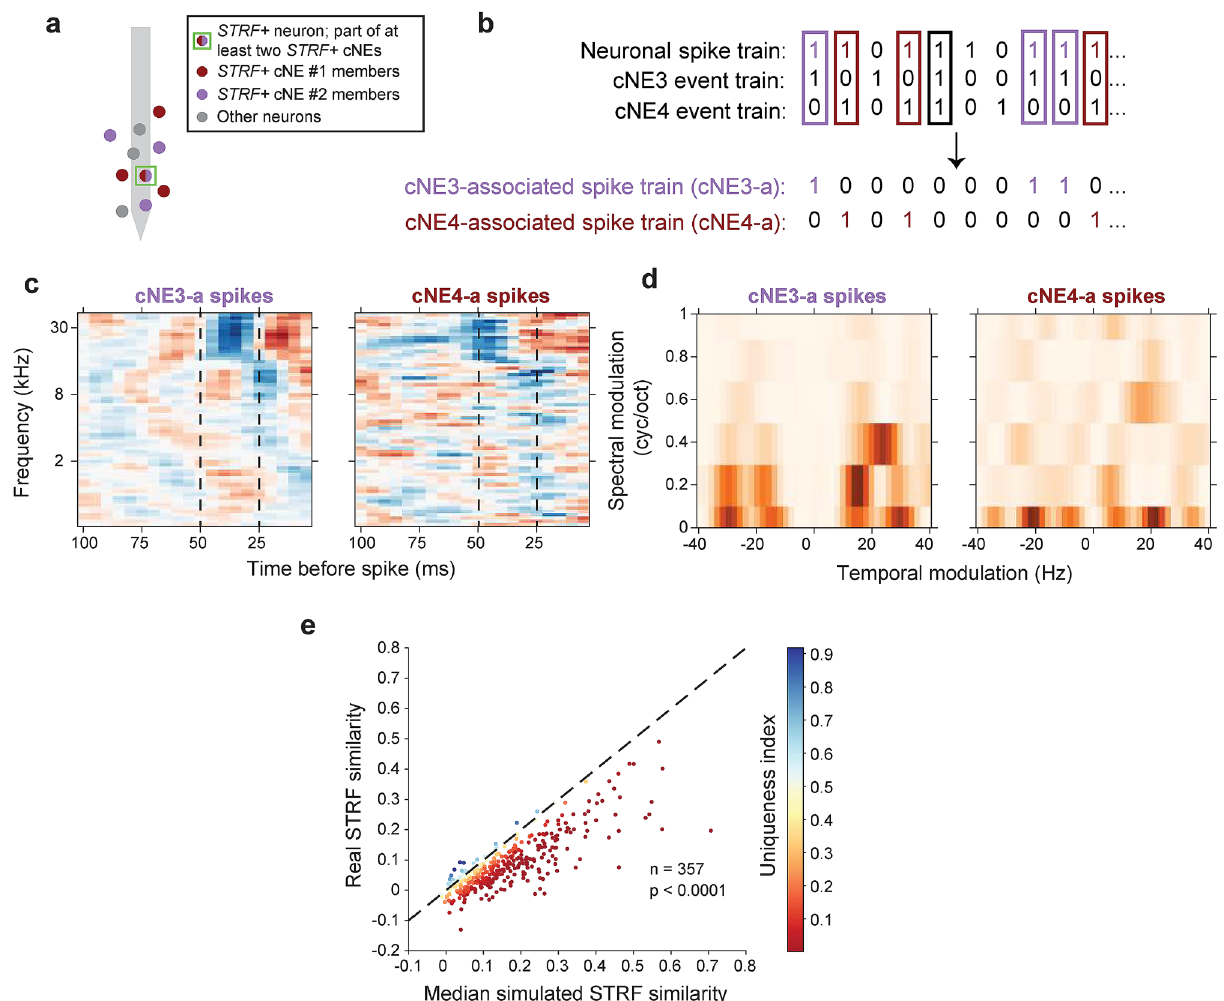
Figure 7. cNE-associated STRFs generated for a neuron participating in two STRF + cNEs are dissimilar. ( a ) Schematic of an STRF + sample neuron (green square) that is part of at least two STRF + cNEs. This neuron is marked part red and part purple to illustrate the splitting of its spikes into smaller subsets. ( b ) Illustration of a neuronal spike train split into two cNE-a subsets. Purple: spikes associated with cNE3; red: spikes associated with cNE4; spikes associated with both cNEs (black rectangle) or neither of the cNEs are omitted. ( c ) Sample STRFs from the two subset spike trains. Vertical black dashed lines demarcate the 25 ms and 50 ms time bins, showing that the STRFs clearly differ in their temporal profile. ( d ) Sample Modulation Transfer Functions from the two subset spike trains. The preferred spectral modulation and temporal modulation frequencies between the two subsets are visually different. ( e ) Real STRF similarity vs median simulated STRF similarity (null distribution; Supplementary Fig. 7a, b) for pairs of cNE-a spike trains across the entire population. Real STRF similarity is significantly lower than the null distribution (≈ 90% below black dashed unity line), implying that spikes associated with different cNEs generated STRFs that were significantly more different than by chance. ( e ) Paired